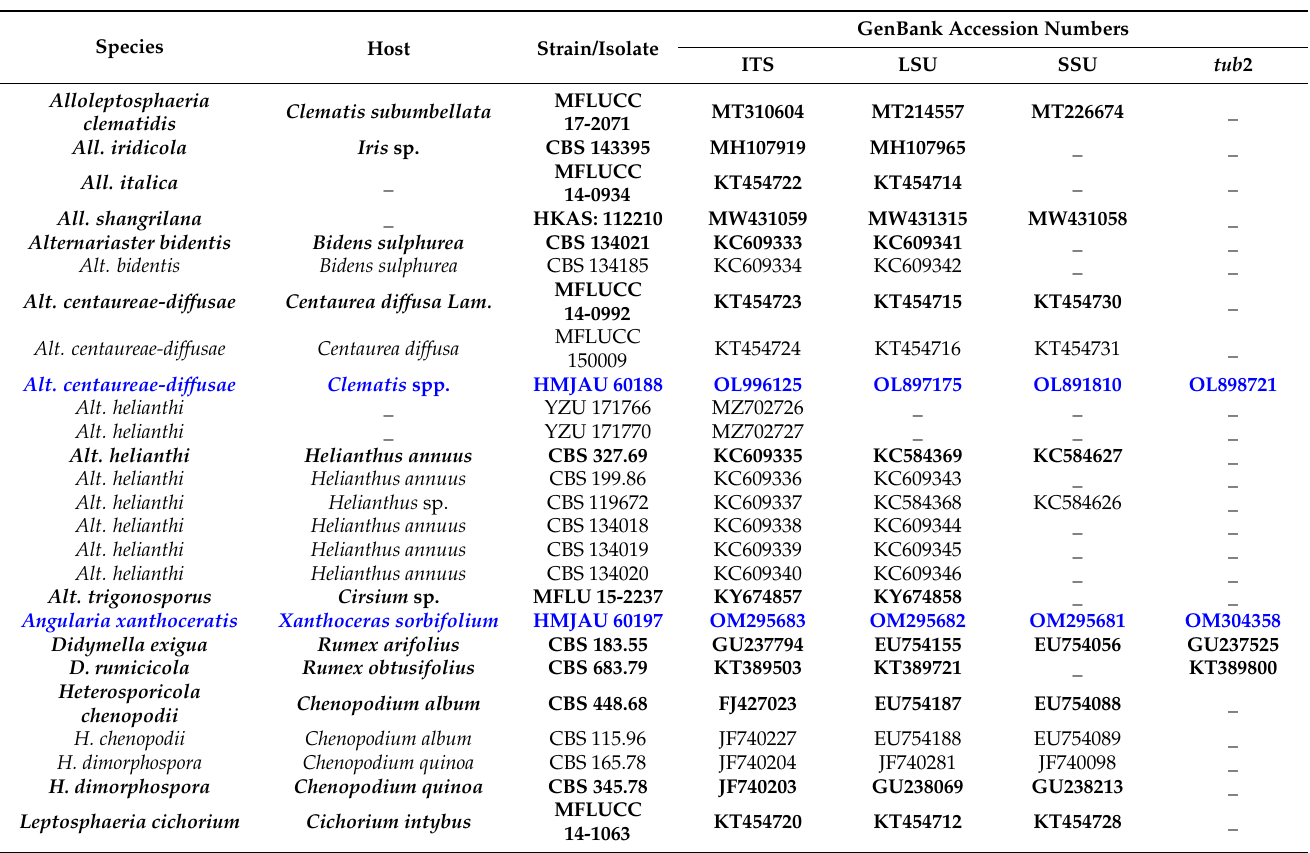
Table 1. Taxa and GenBank accession numbers used in the phylogenetic analyses. The extypes are shown in bold, and newly generated sequences are shown in